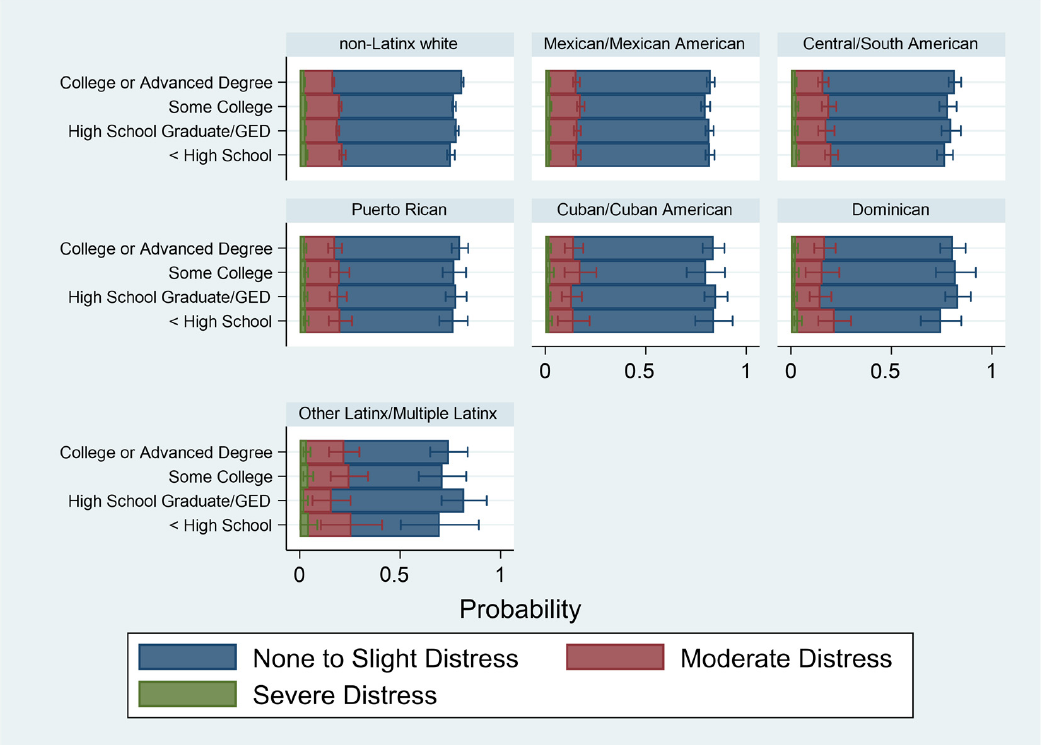
Figure 3. Predicted Probabilities of Level of Psychological Distress by Educational Attainment and Racial/Ethnic Subgroup, 2014–2018 National Health Interview Survey ( n = 71,064). Notes: Figure based on Table 4, Model 3. Accounts for demographic, social, and health